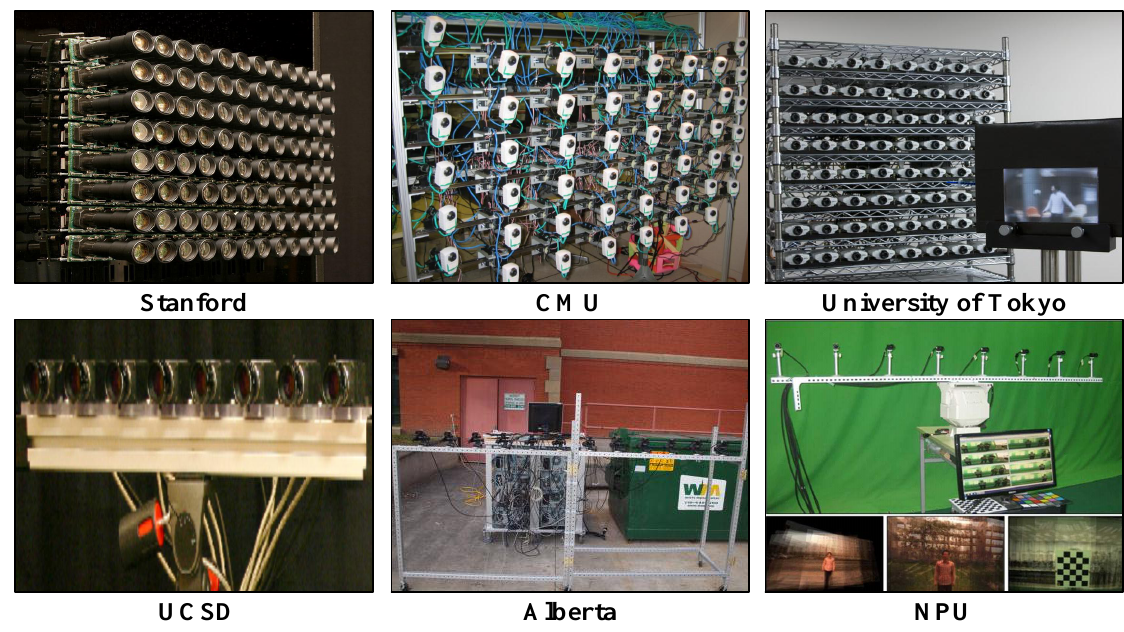
Figure 1. Examples of camera array synthetic aperture imaging sensors. NPU, Northwestern Polytechnical University.